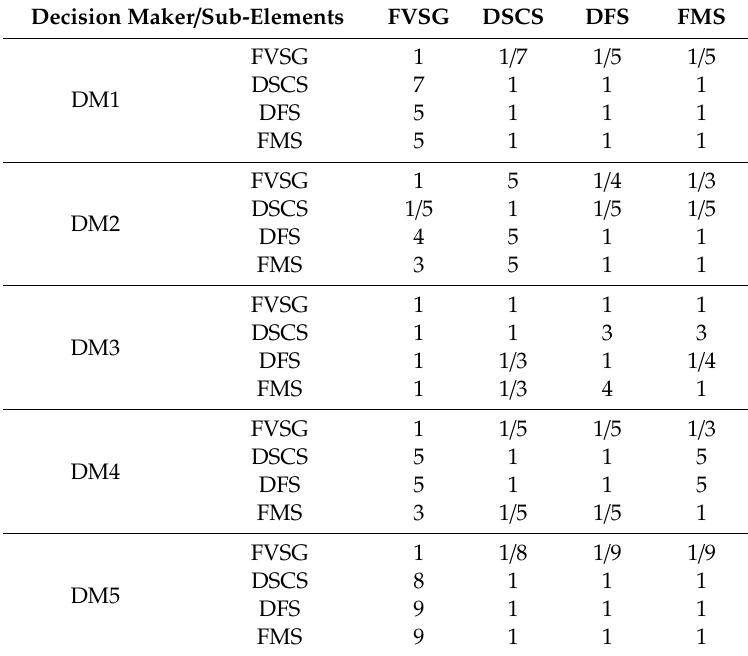
Table 6. Strategic sub-element AHP-pairwise comparison.